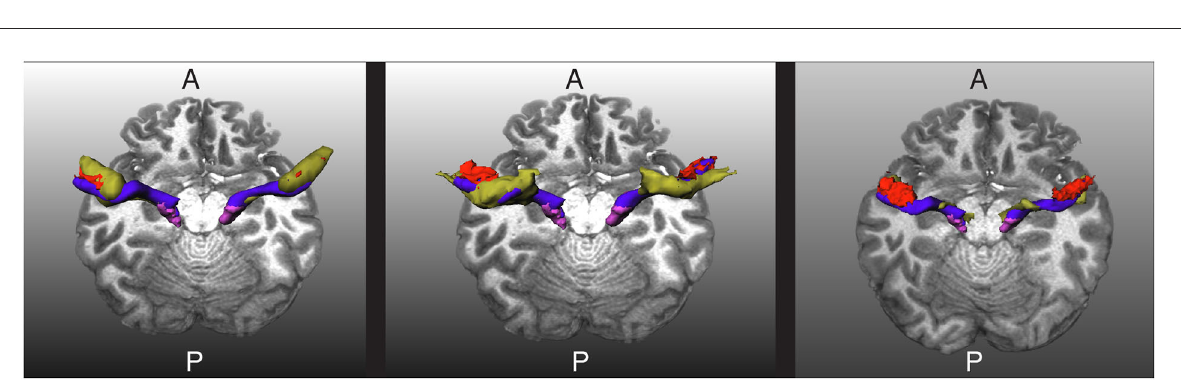
FIGURE5 Visualization of the extracted acoustic radiation for one subject from the human connectome project in blue. The Heschl’s gyrus and medial geniculate nucleus are depicted in red and magenta, respectively. Left: The atlas from Bürgel et al. (2) is shown as a reference in yellow. Middle: The atlas from Maffei et al. (16) is shown as a reference in yellow. Right: The segmentation obtained with XTRACT (20) is shown in yellow as a reference. A and P indicate the anterior and posterior sides of the brain, and T1w is used as a